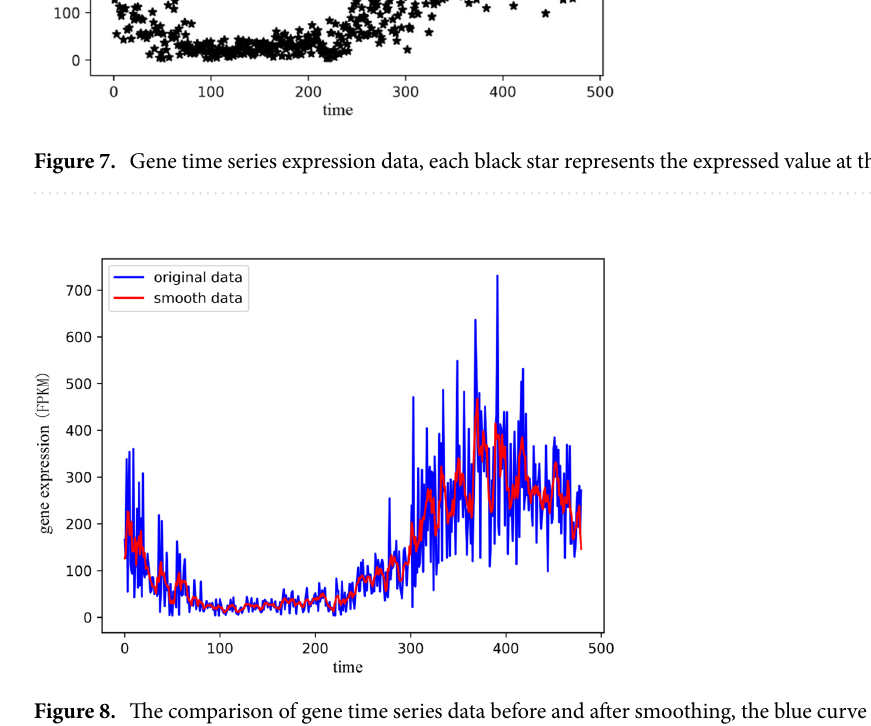
Figure 8. The comparison of gene time series data before and after smoothing, the blue curve represents the distribution of the original time series data, and the red curve represents the data distribution after data smoothing